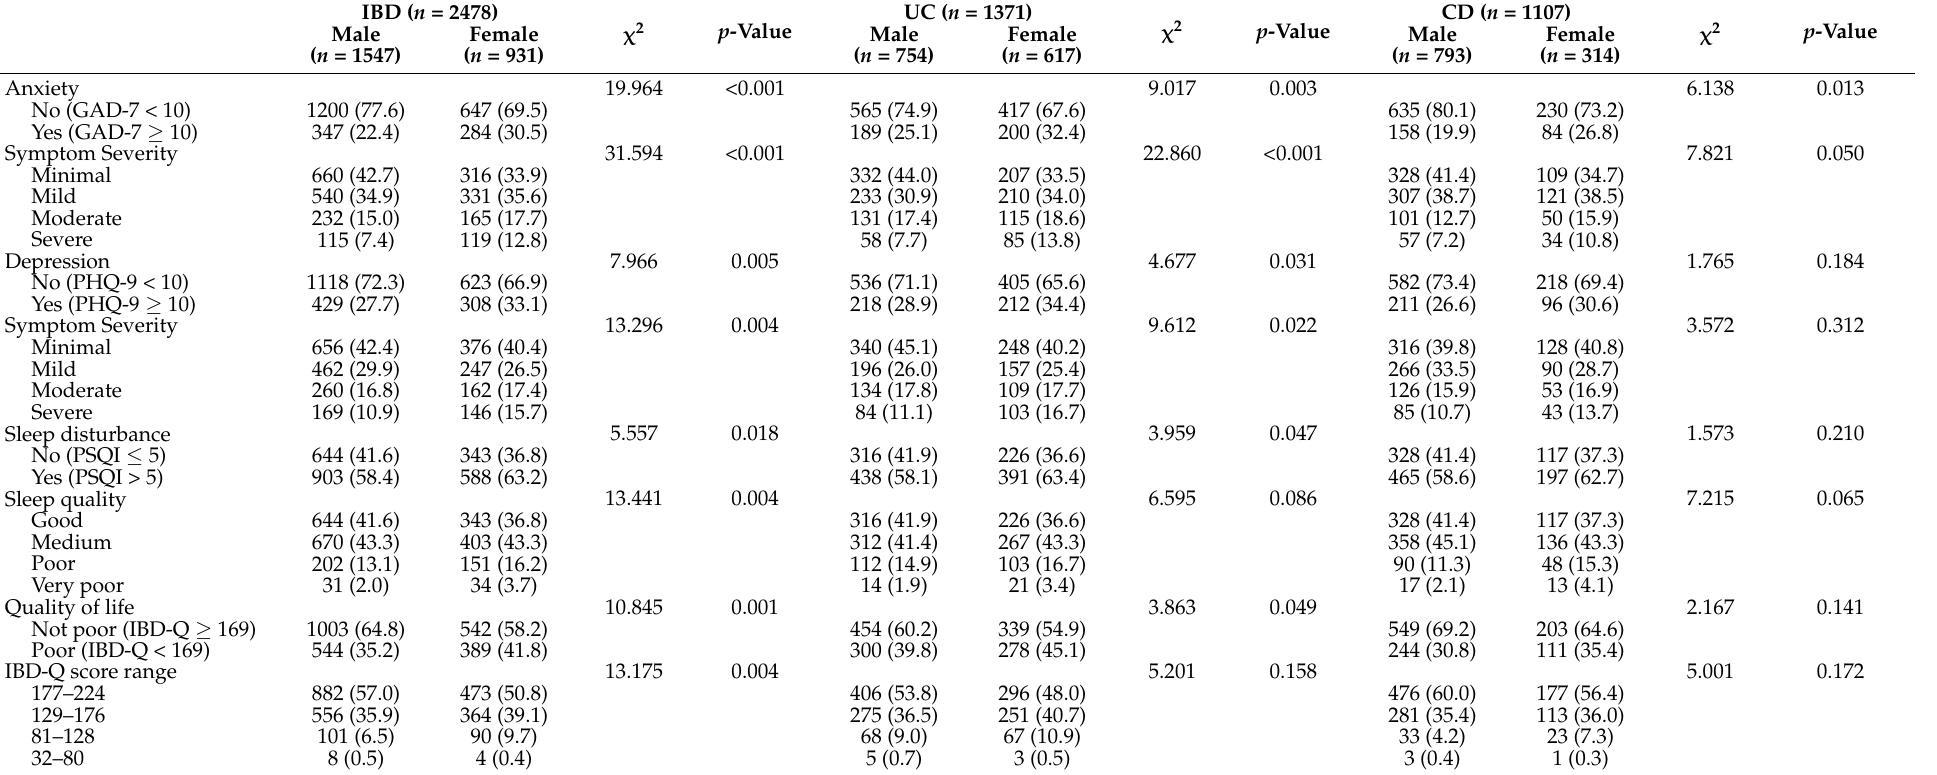
Table 2. Psychological symptoms, sleep quality, and quality of life in IBD patients of different genders ( n